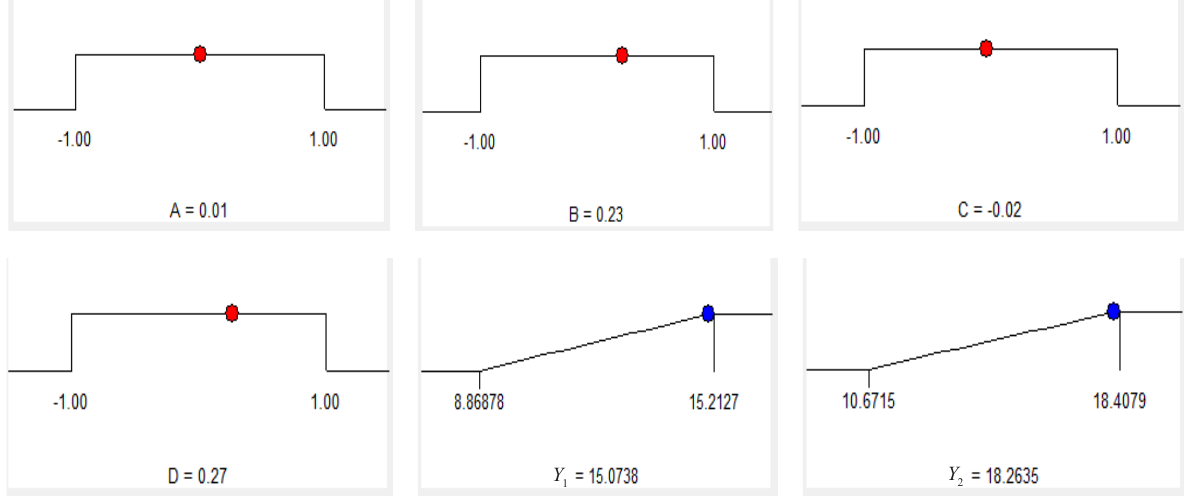
Figure 4 Optimum conditions by solution of